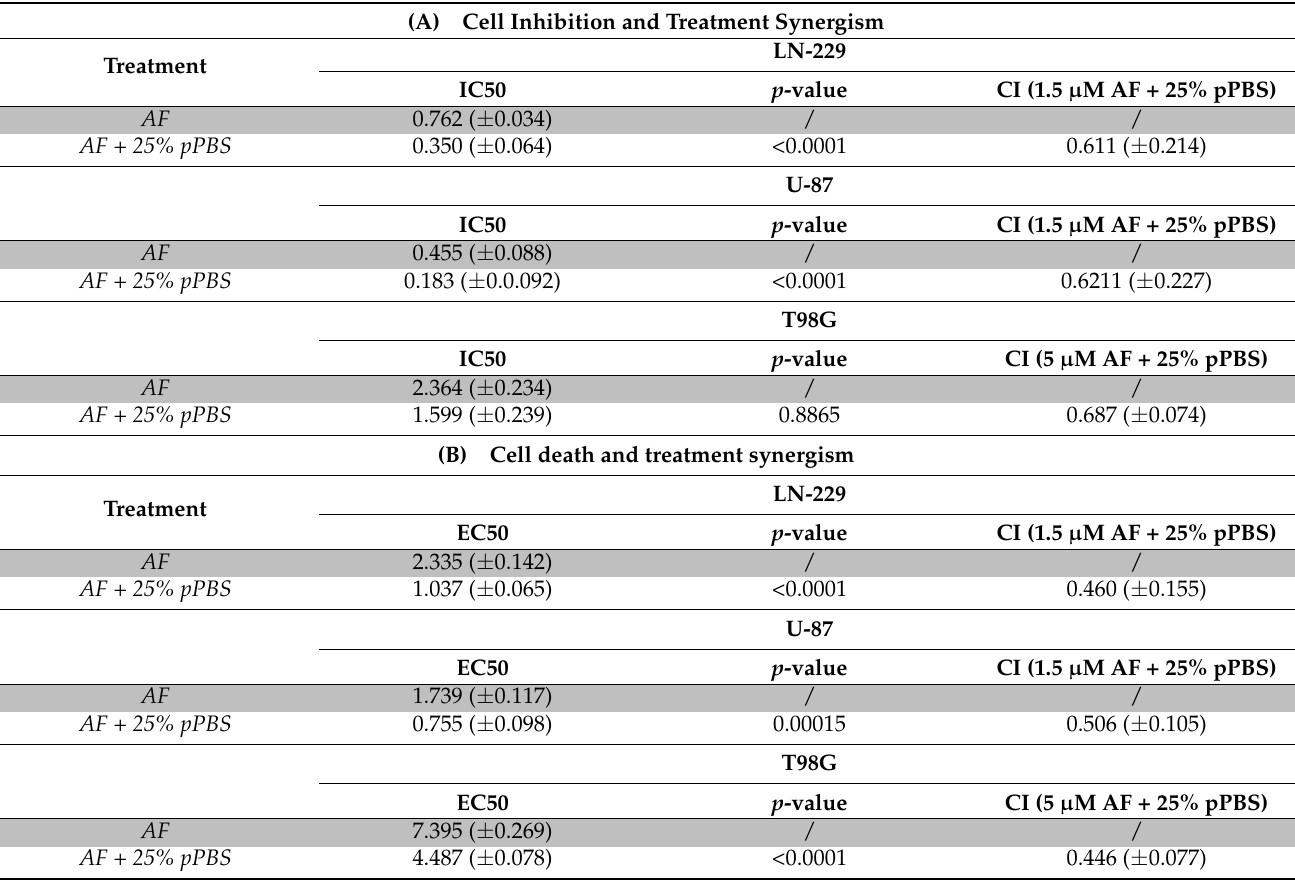
Table 1. Cell death, cell inhibition and synergism of AF and pPBS combination treatment of GBM cell lines. (A) Cell Inhibition and Treatment Synergism